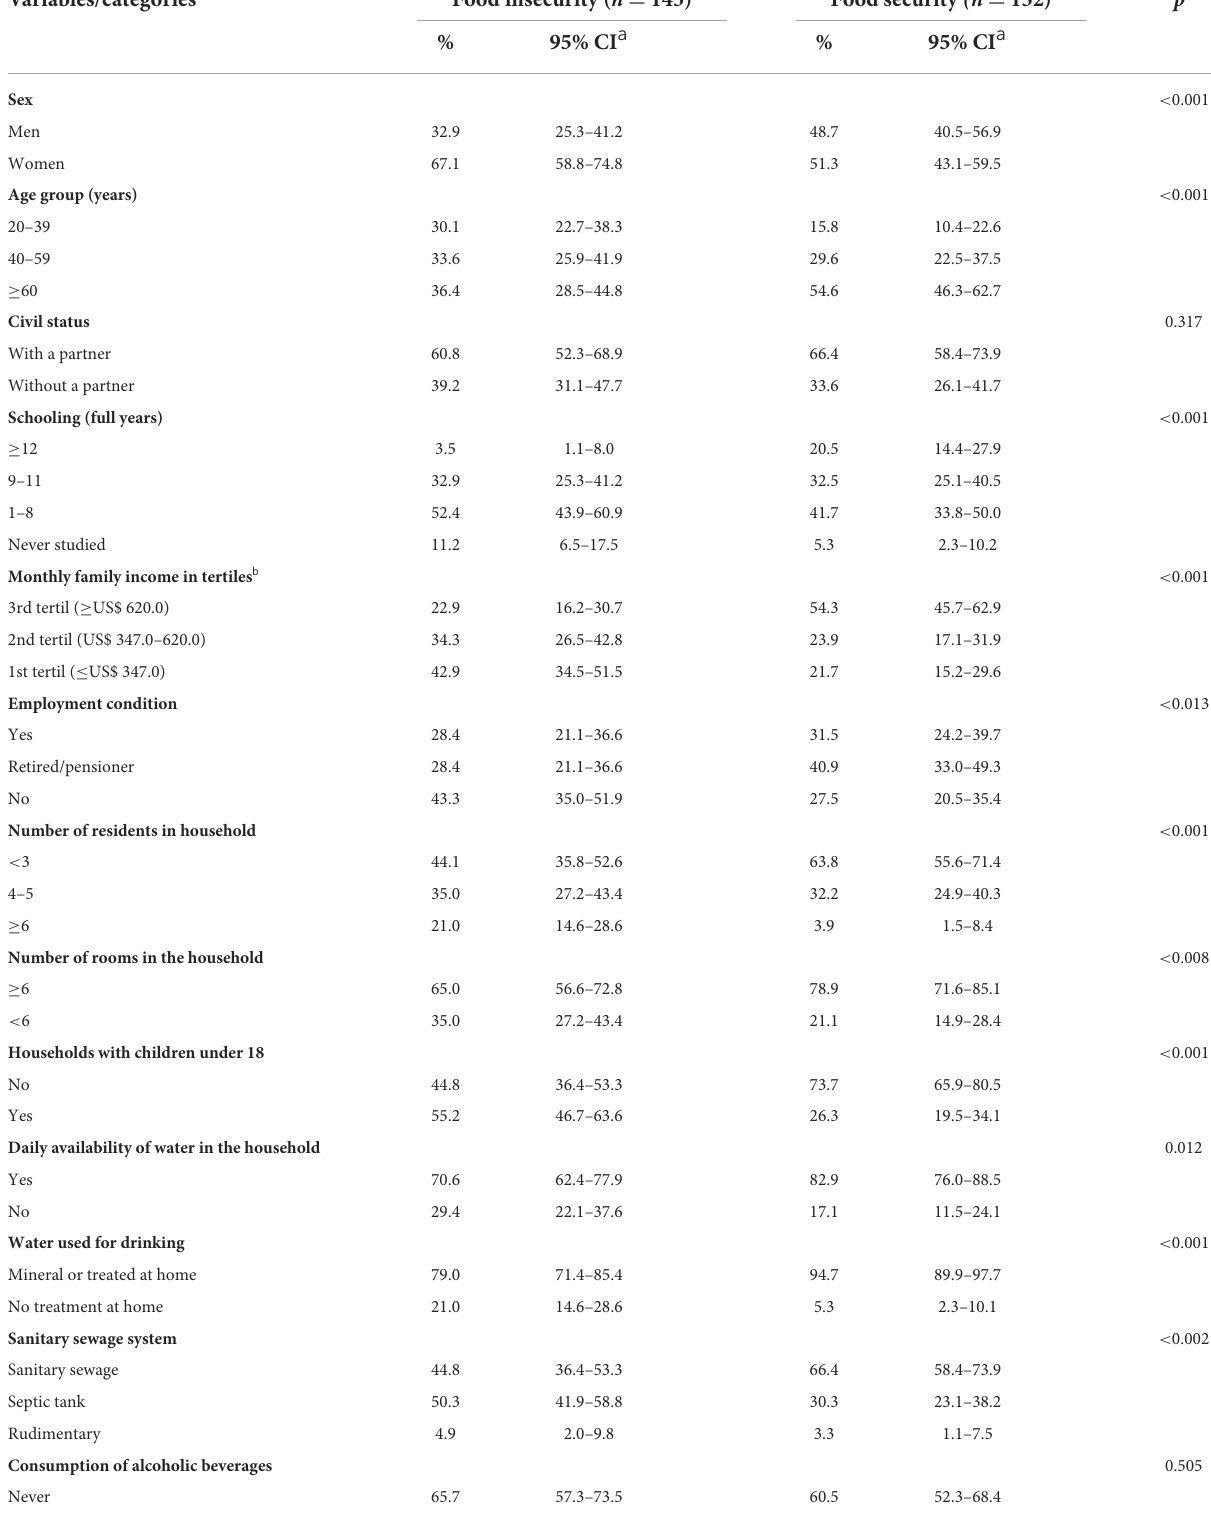
TABLE 1 Socioeconomic, demographic, lifestyle, and health characteristics of adults and older adults according to food security